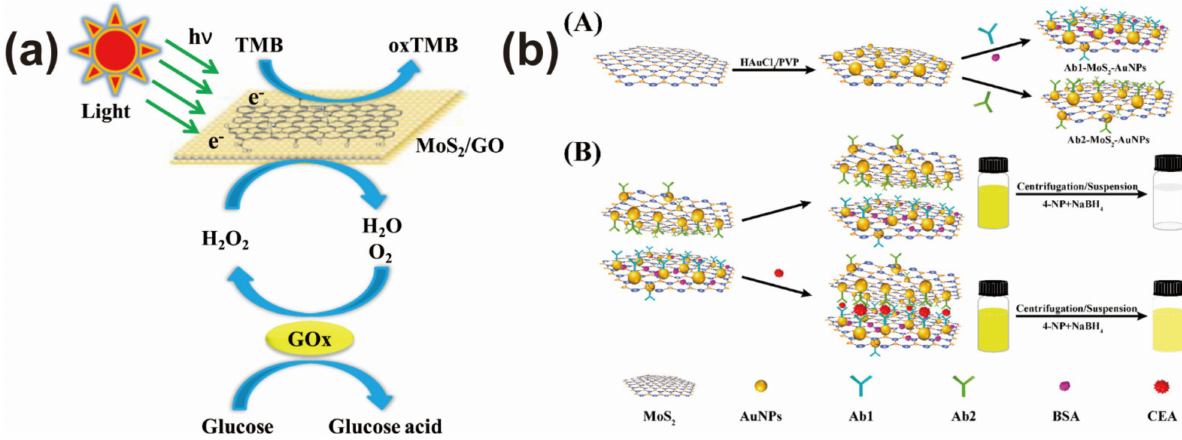
Figure 3. ( a ) Development of ECL biosensor for mucin 1 analysis based on MoS 2 -based nanoprobe. Reprinted with permission from [52]. Copyright 2018, American Chemical Society. ( b ) Illustration of ECL biosensor for concanavalin detection A by using the high-efficient quenching ability of MoS 2 nanoflower. Reprinted with permission from [54]. Copyright 2017, Elsevier.